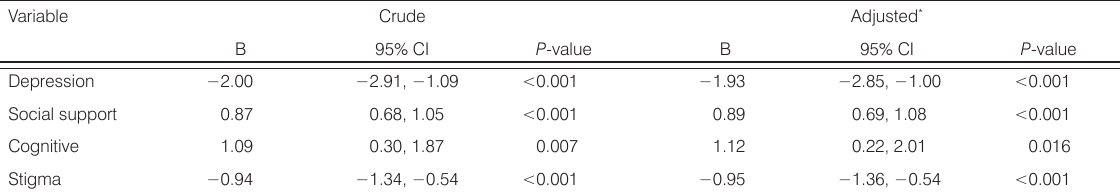
Table 3. Crude and adjusted coefficients of